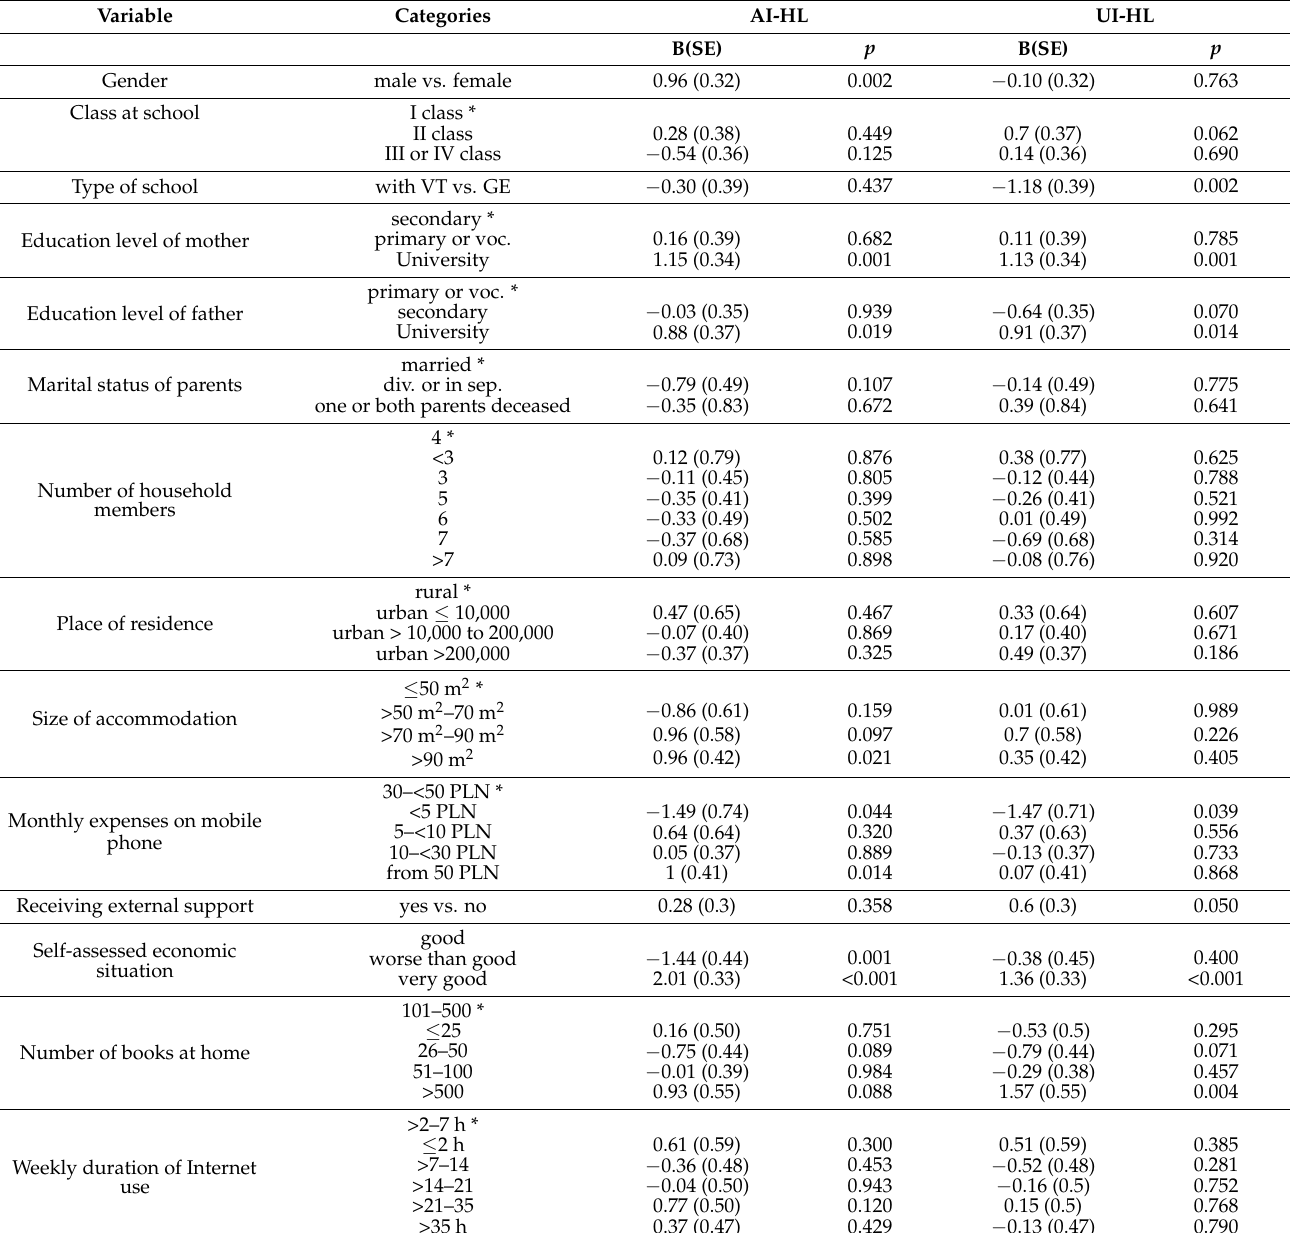
Table 4. Univariate linear regression models for AI-HL and